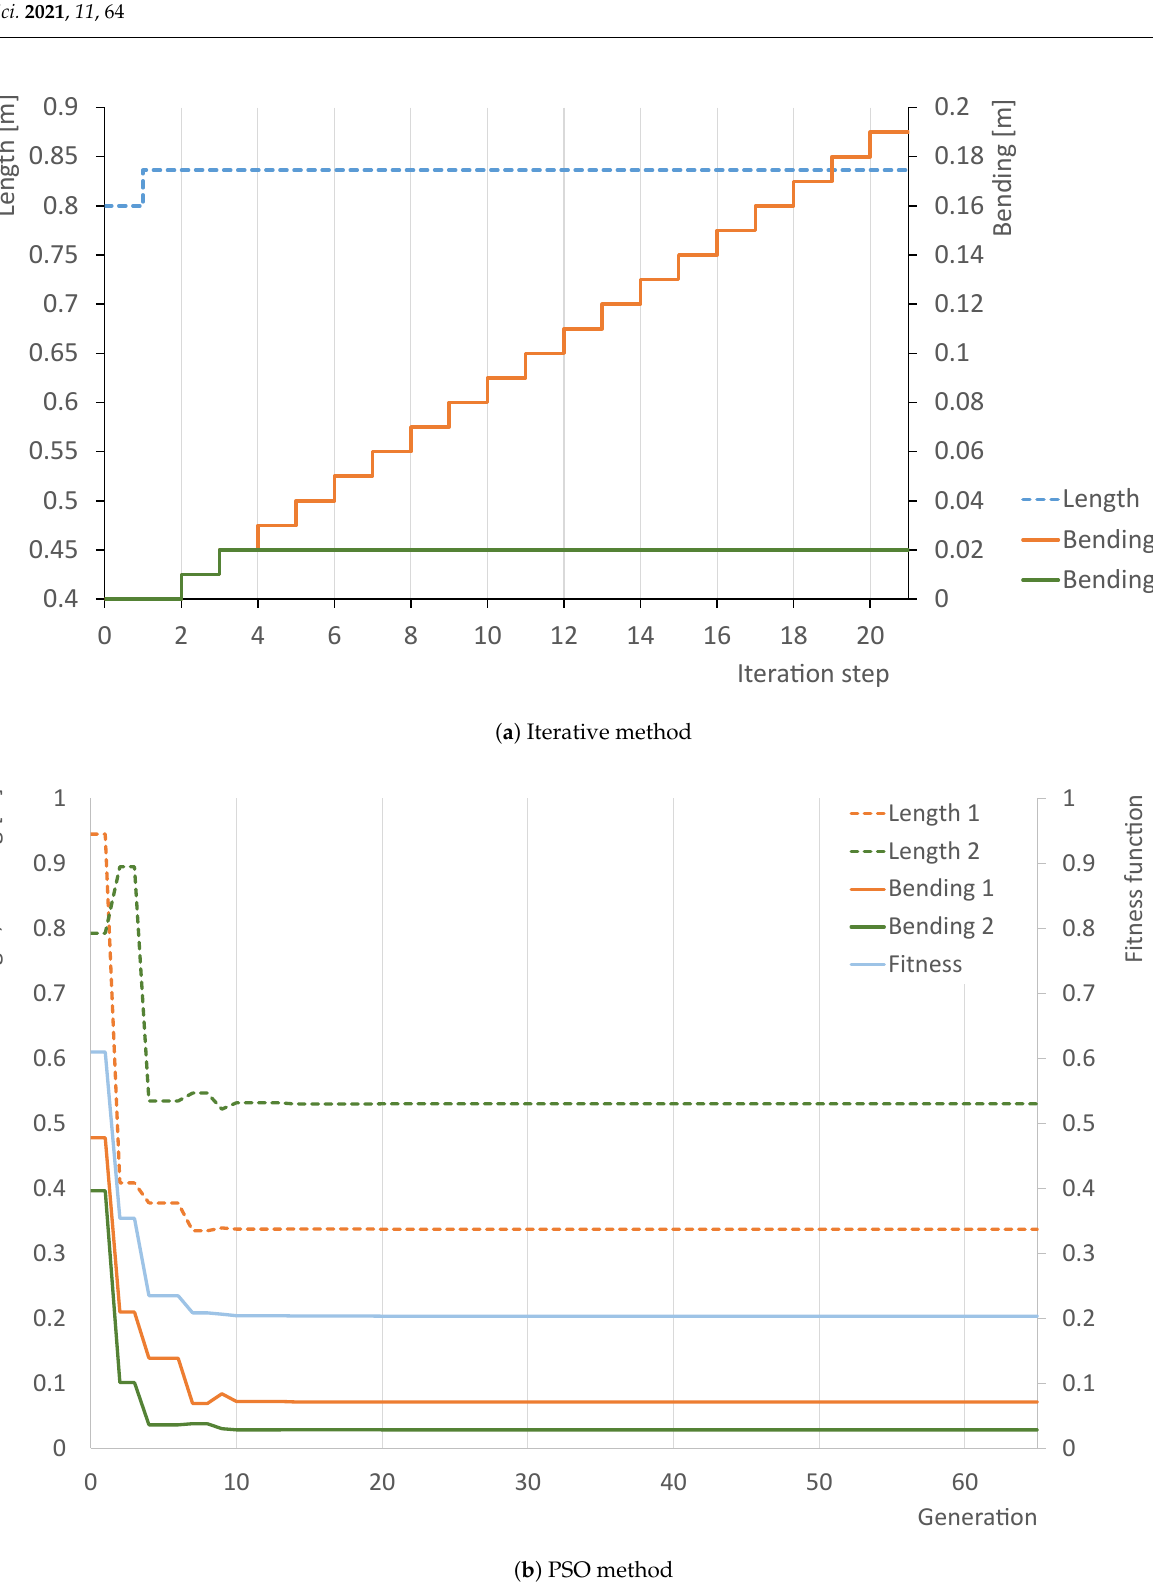
Figure 15. Graphs for the third testing workplace. ( a ) Modifications made to the robot structure in individual iteration steps during the optimization algorithm (the sums of arm lengths and individual lower and upper arm bending amounts are shown). ( b ) Selected parameters of the best particle with the PSO algorithm (the lower and upper arm lengths and bending amounts and the fitness function value are